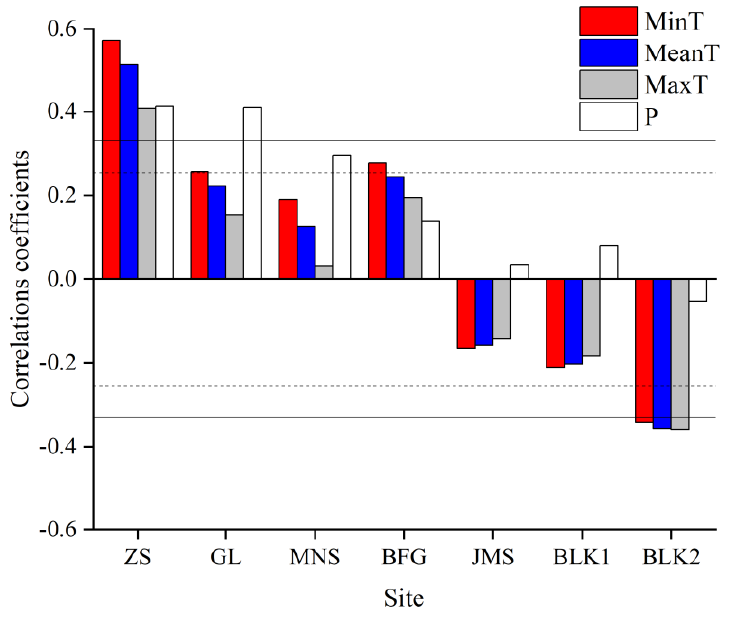
Figure 6. The correlation between the chronology and annual climate factors during 1960–2019. MinT: mean minimum temperature, MeanT: mean temperature, MaxT: mean maximum temperature and P: precipitation. The 95% and 99% confidence levels were indicated by dashed and solid lines, respectively.